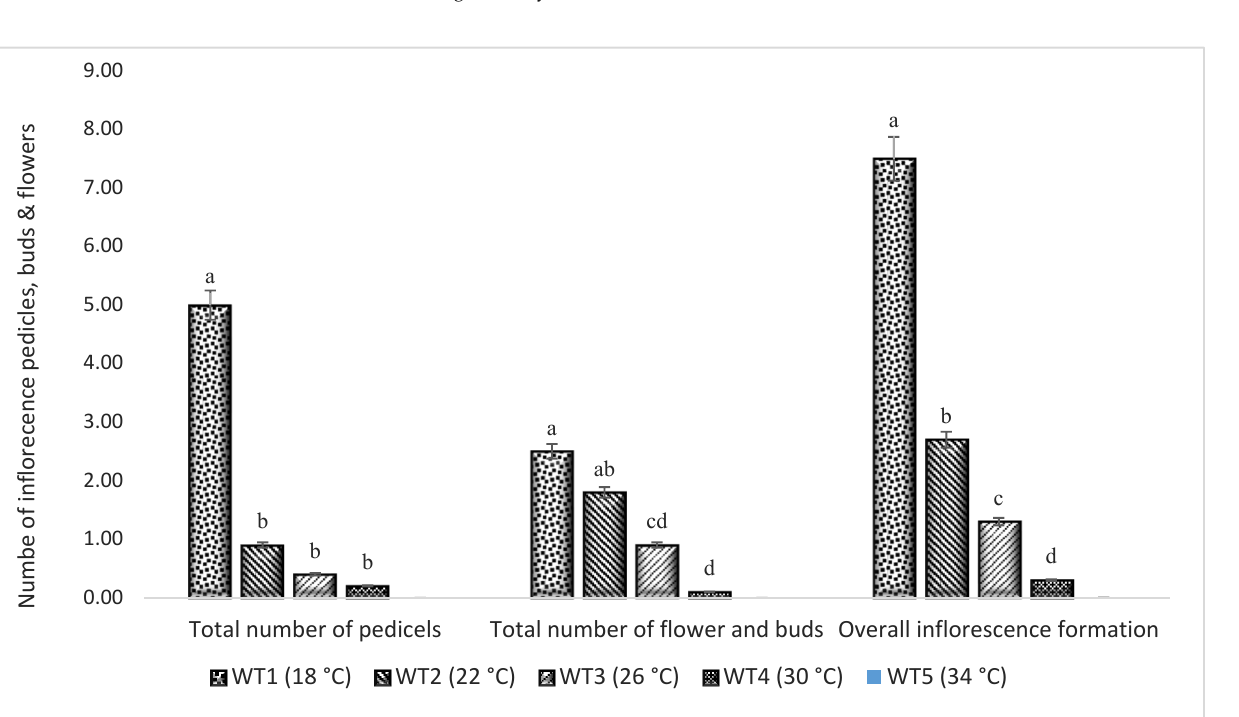
Figure 6. The relationship between root zone water temperatures and inflorescence formation. Note: The bars presented here are means ± SE. Bars with different letters are significantly different at p ≤ 0.01 (**) (total number of flower and buds; overall inflorescence formation) and p ≤ 0.001 (***) for the total number of pedicels as calculated by Fisher’s least significant difference.